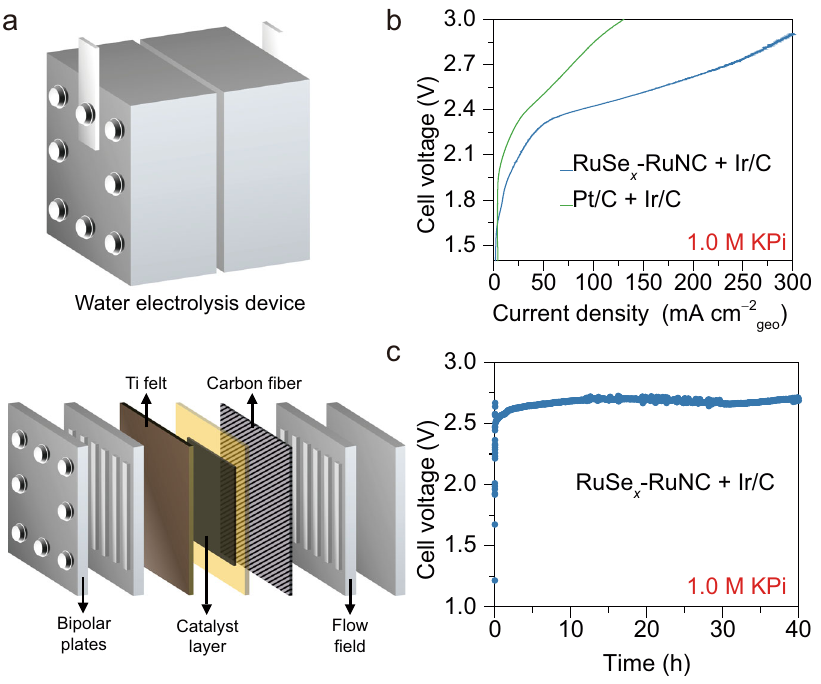
Fig.6|Neutralwaterelectrolysisdeviceperformance.a Schematicillustrationof a typical anion-exchange-membrane water electrolysis device. b Electrocatalytic water splitting performance of the ReSe x – RuNC + commercial Ir/C and the